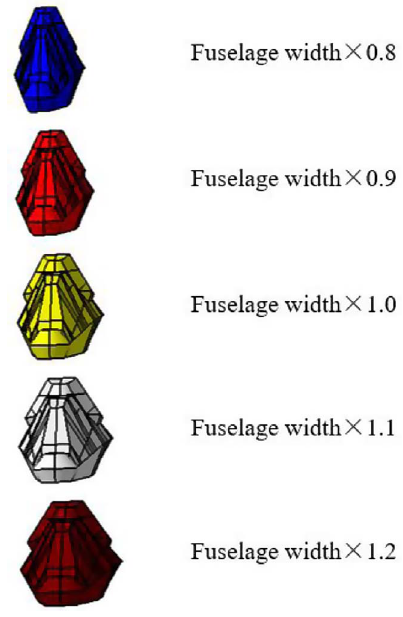
Figure 17. Fuselages with different width